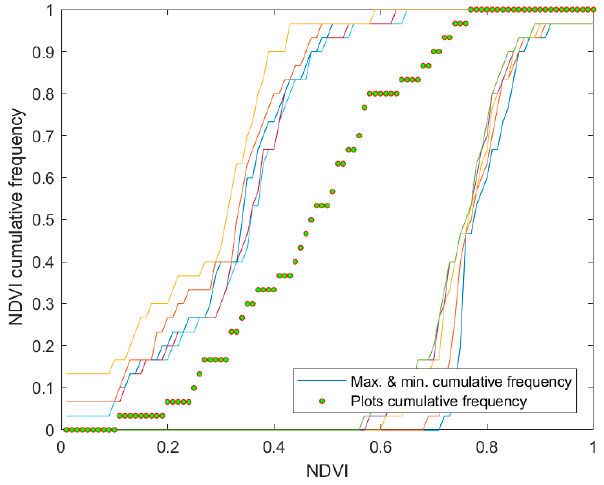
Figure 4. Comparison of NDVI distribution between study area (green dots) and over the whole image (five highest and lowest values as external lines). Area of the Chequilla fire, June 2020.